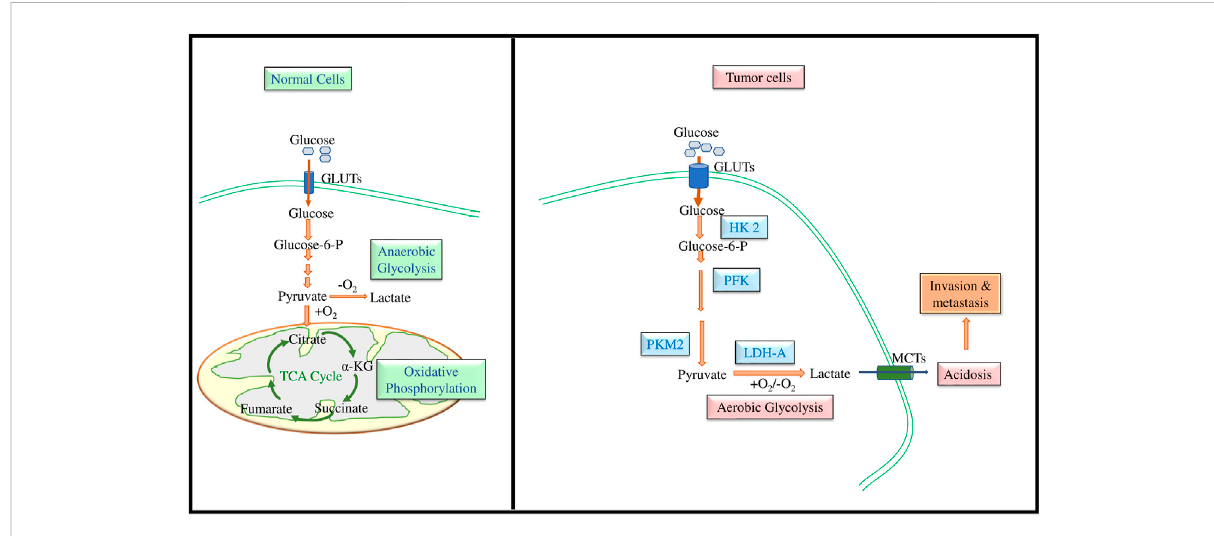
FIGURE 1 Role of GLUTs in the accelerated glycolysis of neoplastic cells. Neoplastic cells display an upregulated expression of GLUTs for increased glucose uptake, which is rapidly metabolized to lactate leading to the production of a high amount of ATP and biosynthetic